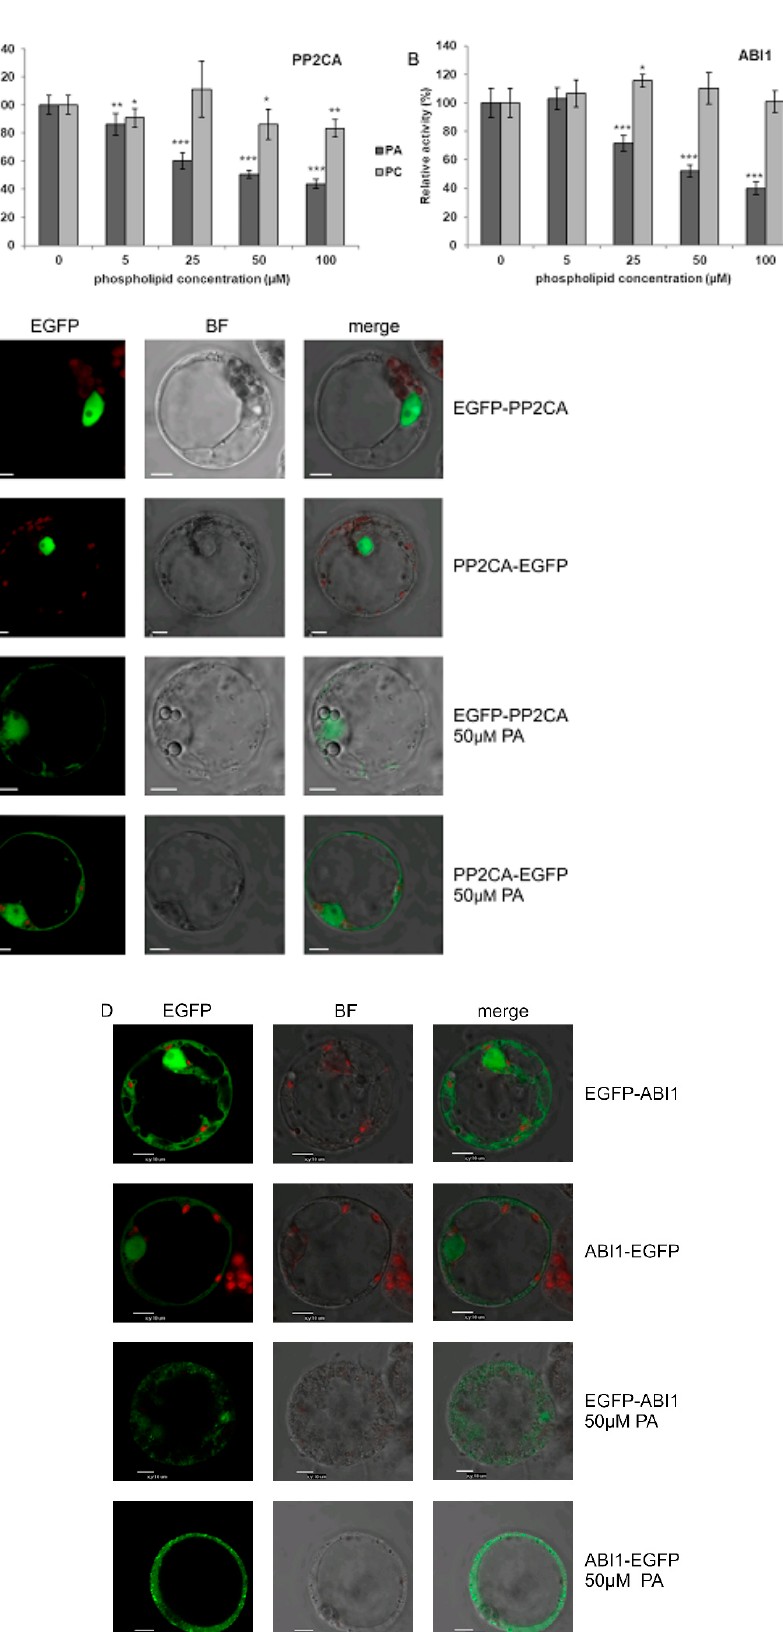
Figure 6. E ff ect of PA on the activity and subcellular localization of PP2CA phosphatase. ( A , B ) E ff ect of PA and PC on the activity of PP2CA ( A ) with ABI1 ( B ) used as a control. The activity of